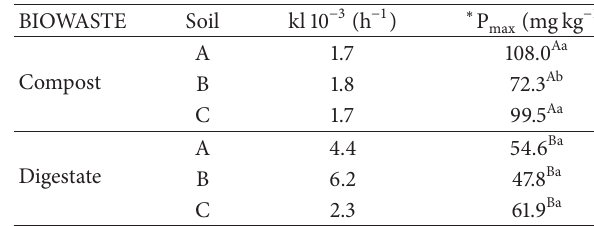
Table 3: First-order kinetic constant (kl) and P maximum leached estimated (P max ) for each biowaste and amended soil